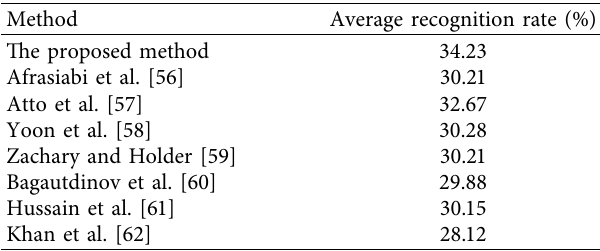
Table 4: Compared with other approaches on MLB-YouTube classes.